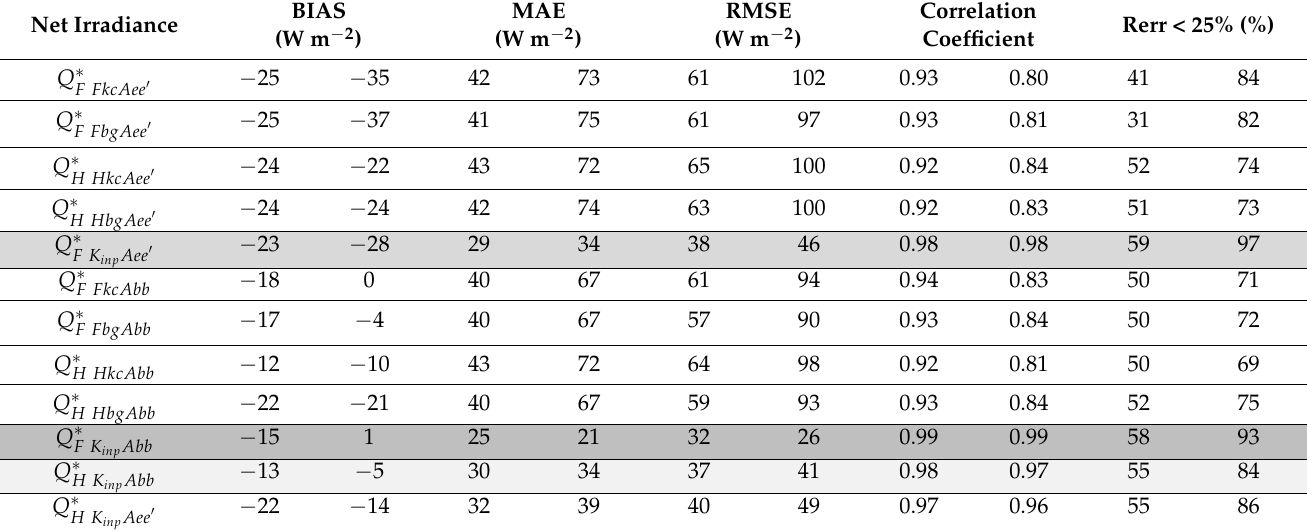
Table 9. Statistical errors and percentages of cases in which the relative errors were smaller than 25% (R err < 25%) in the calculations of the net irradiance, Q ∗ . We used the next symbols in the table: Foken [11] net radiation model Q ∗ and F Holtslag and Van Ulden [5] net radiation model Q ∗ . The low index used K inp for the measured global solar radiation H and Fkc , Fbg , Hkc and Hbg for its assessment depending on Foken’s or Holtslag’s clear sky calculation and cloudiness correction. Aee (cid:48) represent the Nyren and Gryning [37] and Abb Beljaars and Bosveld [38]-type parameterizations of albedo. The second column inside the main columns represents statistical errors of the net radiation but only for period with high solar elevation when the estimated sensible heat flux based on De Bruin and Holtslag [10] was positive. Gray—methods with higher correlation coefficients.